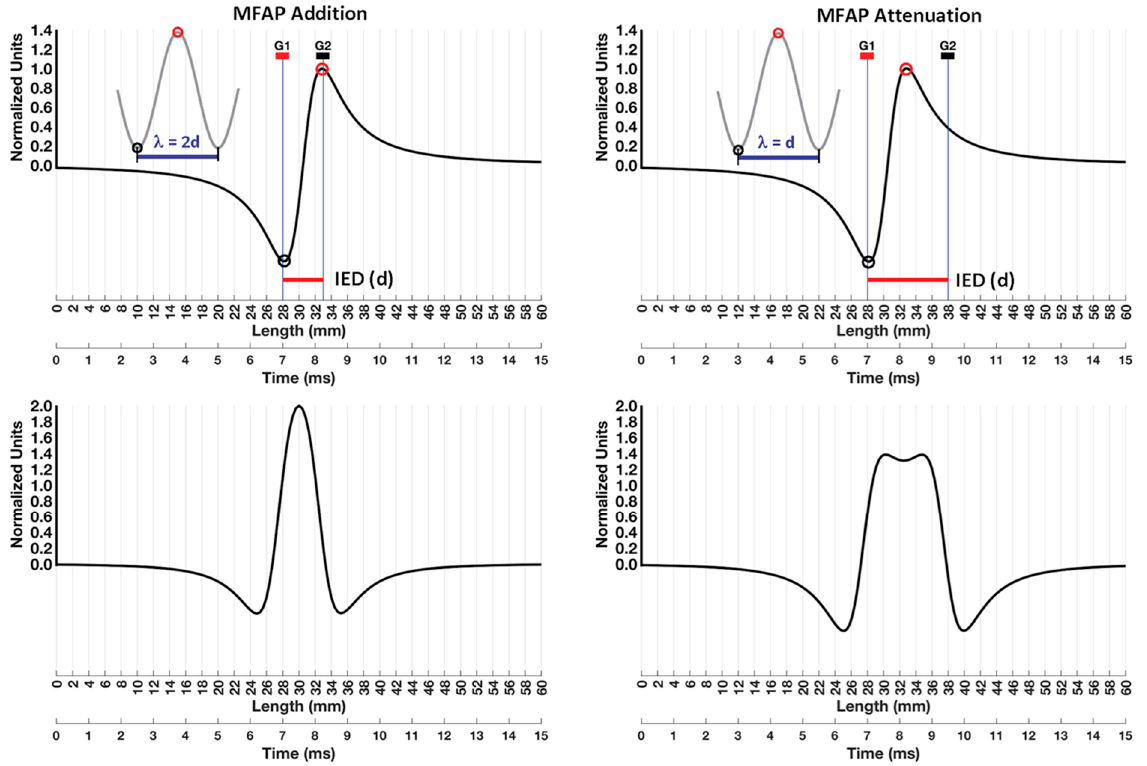
Figure 11. An illustration of the interaction of wavelength ( λ ) and interelectrode distance (IED). The top left panel shows the muscle fiber action potential MFAP relative to G1 and G2 with an IED of 5 mm. The depolarization and repolarization peaks align with G1 and G2, respectively. The amplitude is normalized so that the maximum positive value is 1 unit. The grey sinusoid depicts the perfect addition wavelength ( λ ). The resulting bipolar MFAP has a peak amplitude of two units (bottom left panel). The top right panel shows the same MFAP but now the IED has been increased to 10 mm. The grey sinusoid depicts the wavelength ( λ ) associated with attenuation. Under these conditions, the bipolar MFAP experiences attenuation (bottom right panel). The peak amplitude of the bipolar MFAP was reduced to 1.438 units.